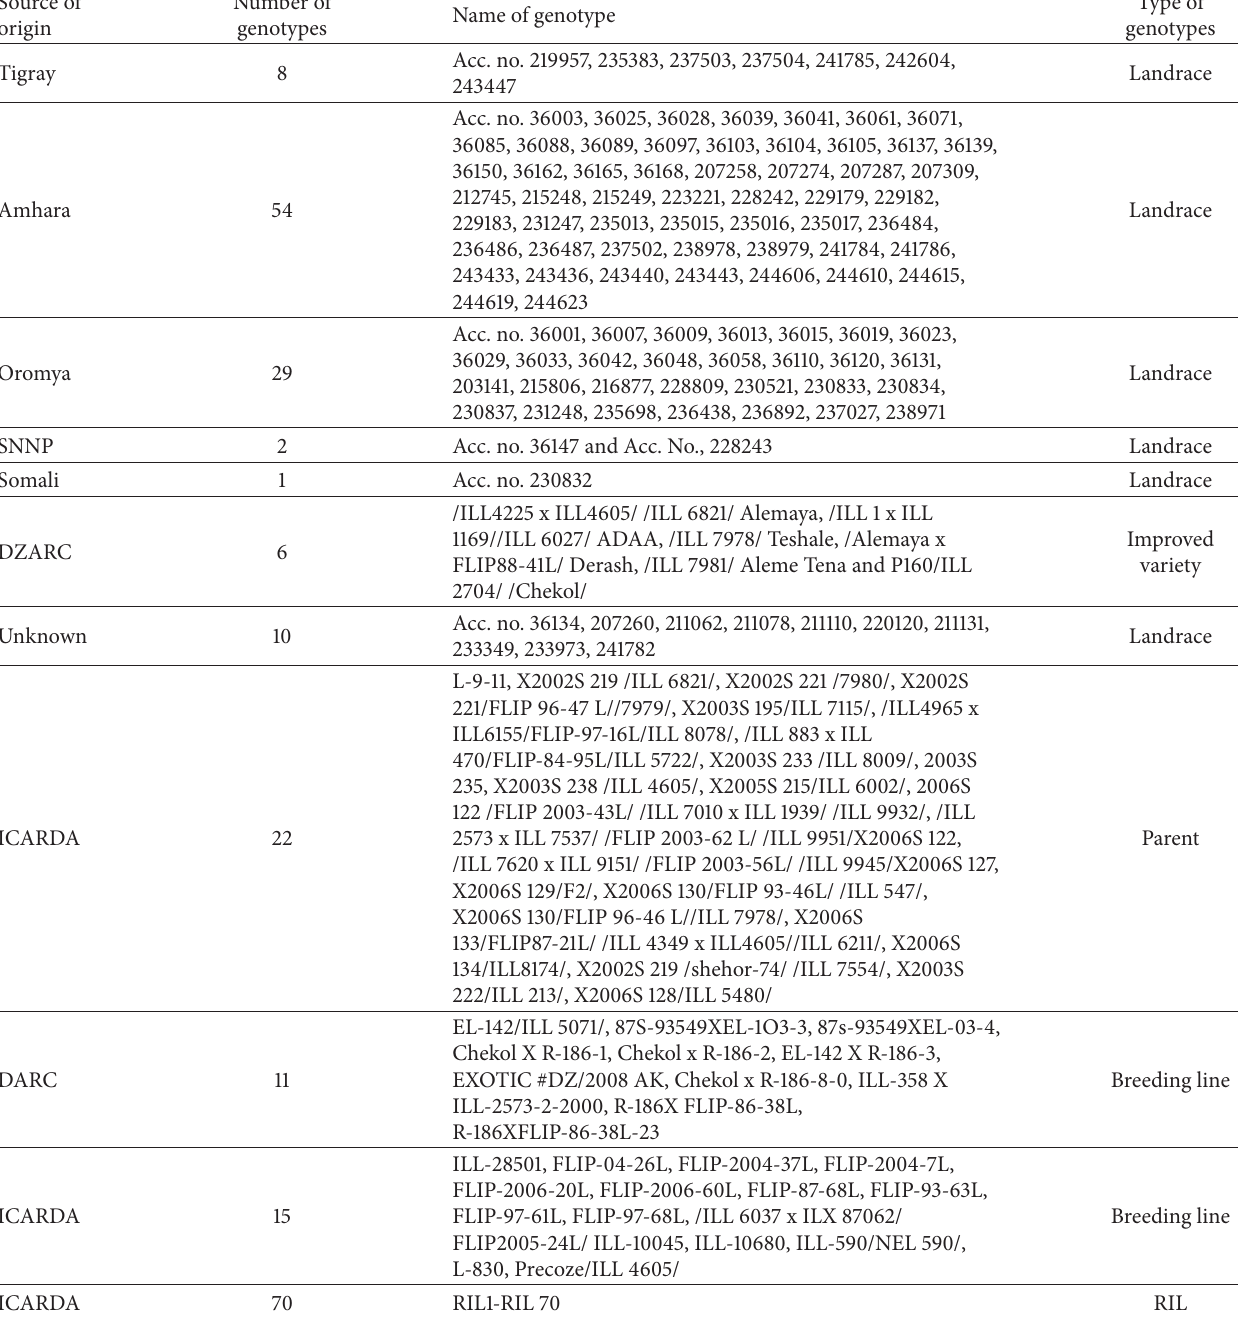
Table 2: List of genotypes and their